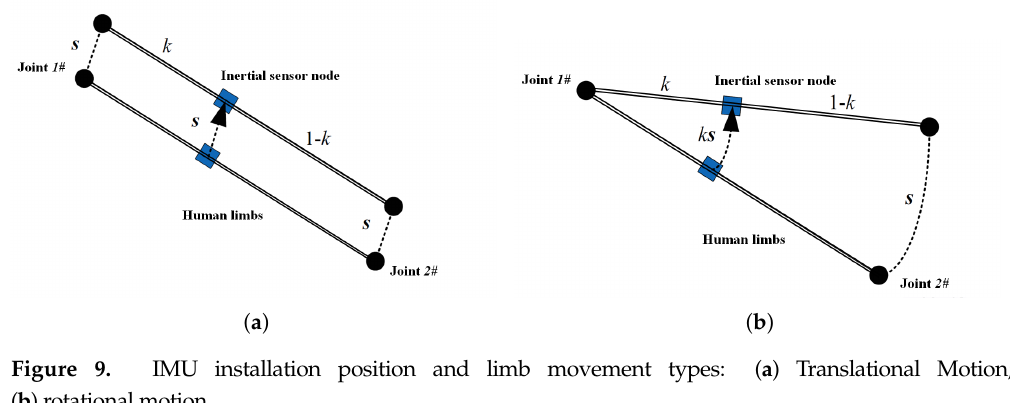
Figure 9. IMU installation position and limb movement types: ( a ) Translational Motion; ( b ) rotational